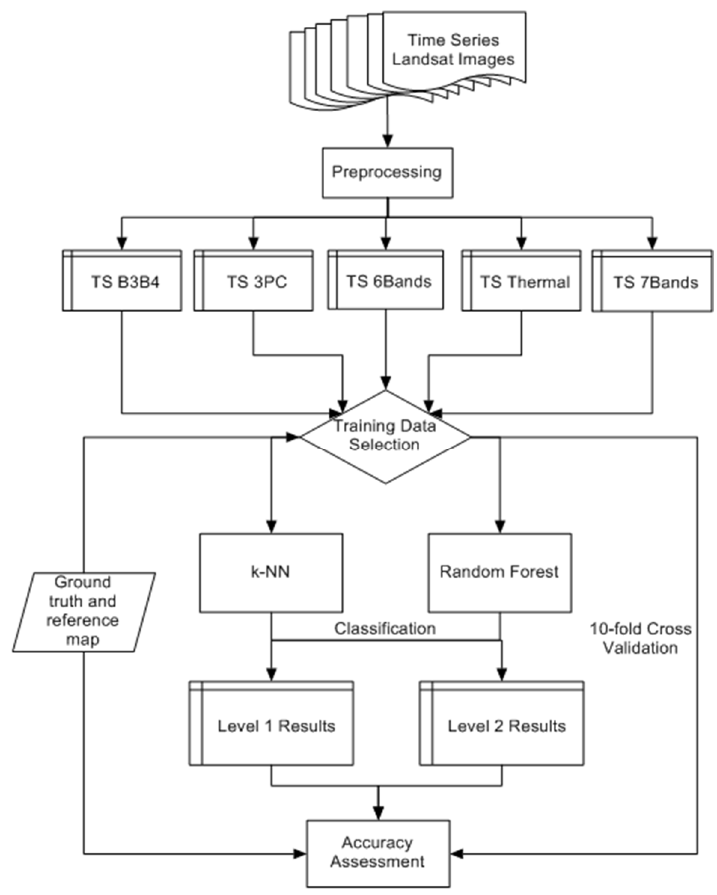
Figure 3. Flowchart of the land cover classification and accuracy assessment process: the time series images were derived from the Landsat 4/5 TM images by preprocessing including: the Band 3 and Band 4 combination (TS B3B4), first three principal components (TS 3PC) of the VIS/NIR bands from TM images, six bands combination except the thermal band (TS 6Bands), the thermal band (TS Thermal) and all the bands combination (TS 7Bands); then based on the ground truth and reference maps training data were selected and used for the k-nearest neighbor and Random Forest algorithms for Level 1 and Level 2 classification; 10-fold cross validation was applied to the both classification methods and then calculated for the accuracy